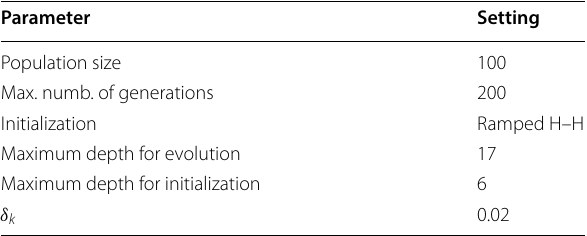
Table 2 GP parameters used in our